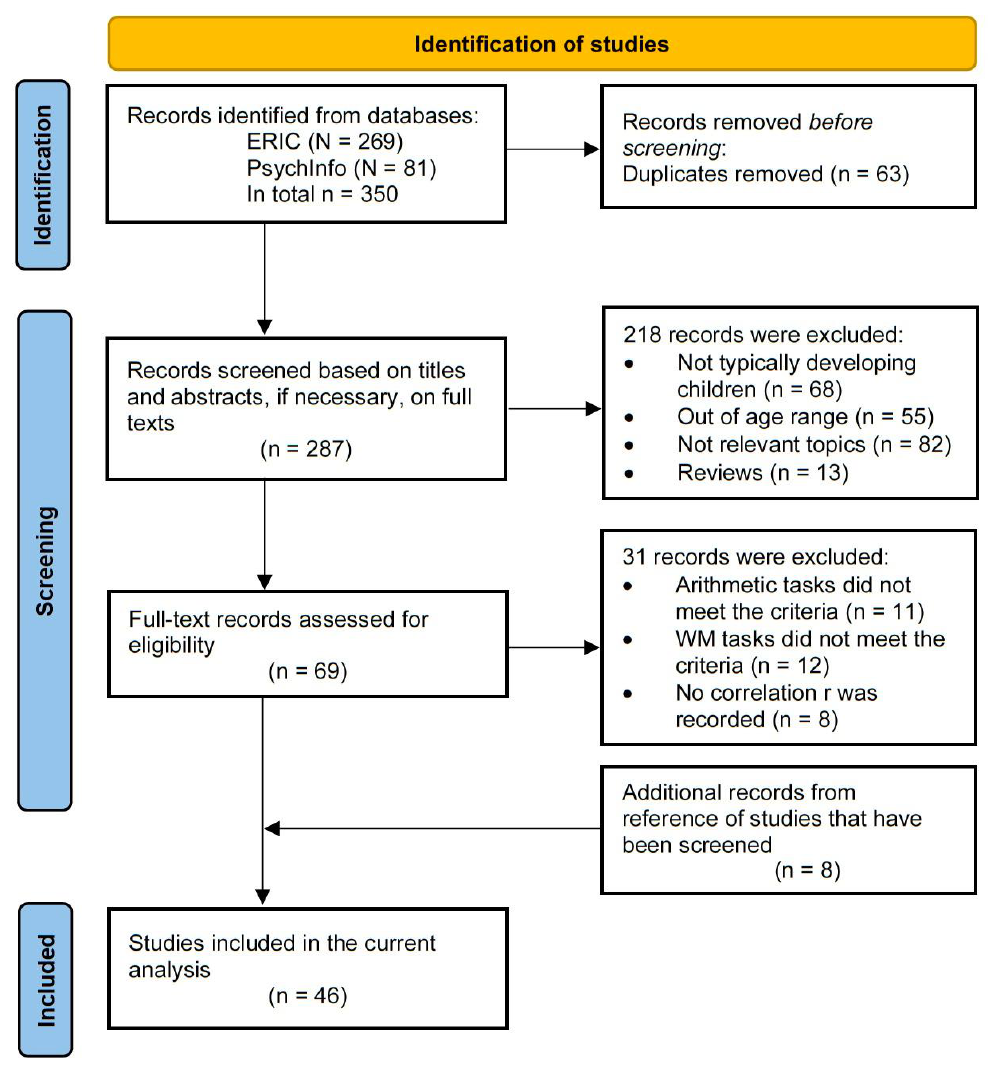
Figure 1. The PRISMA flow chart of literature search and screening process.